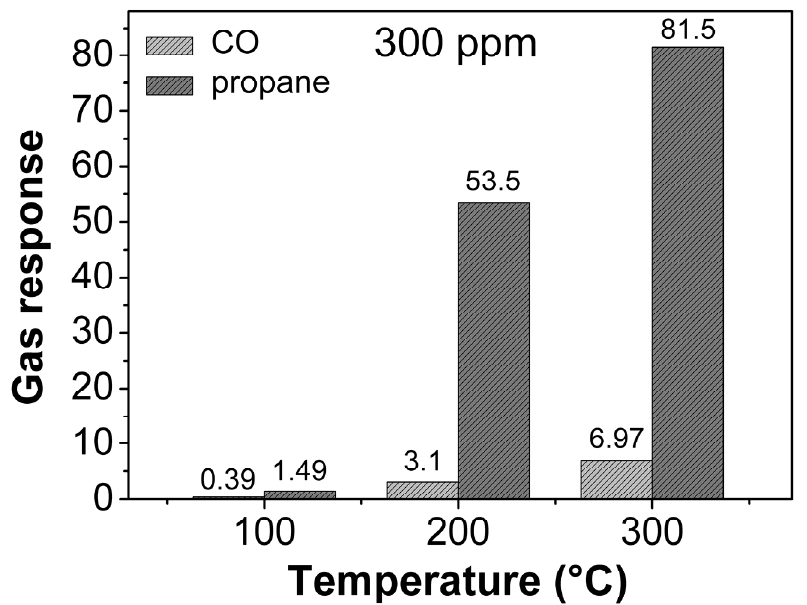
Figure 13. Comparison of the response to 300 ppm of CO and 300 ppm of propane at 100, 200, and 300 °C.